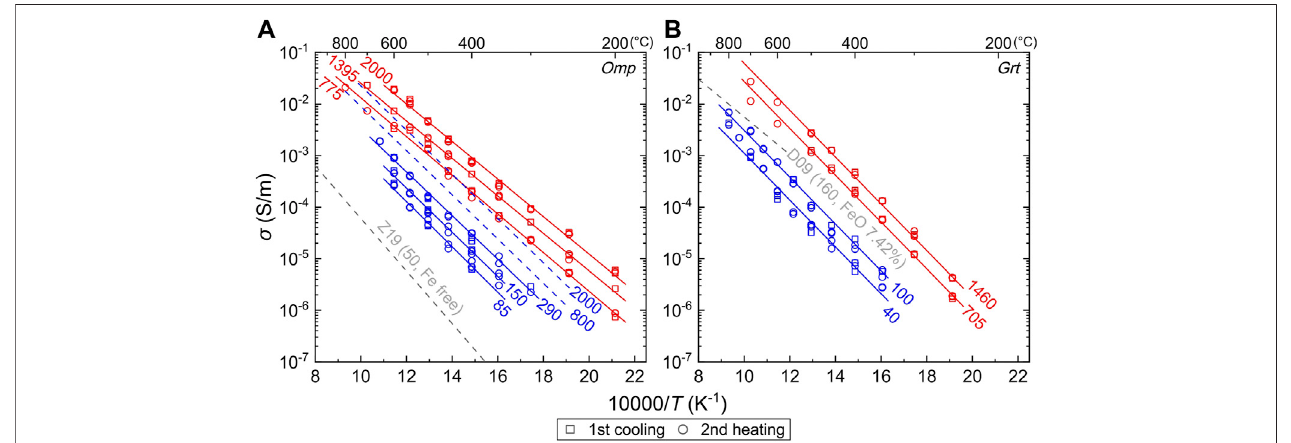
FIGURE3| Conductivityof (A) omphaciteand (B) garnet.Redandbluedenotewater-poorandwater-richconditions,respectively,withwatercontentshown(ppm H 2 O)foreachsample. (A) Redandbluesolidlinesaremultilinear fi ttingsby Eq.2 tothedataofwater-poorandwater-richsamples,respectively,anddashedbluelinesby applying the parameters of water-poor omphacite to water-rich conditions (see text). (B) Solid lines are multilinear fi ttings to the data of all samples, marked as red and blue for water-poor and water-rich samples, respectively. Uncertainty is usually smaller than symbol sizes. Compiled data: Z19, Zhang et al. (2019) at 3 GPa for a synthetic Fe-free omphacite (50 ppm H 2 O); D09, Dai and Karato (2009) at 8 GPa for a pyrope (~7.42% FeO and 160 ppm H 2 O). Omp , omphacite; Grt , garnet.